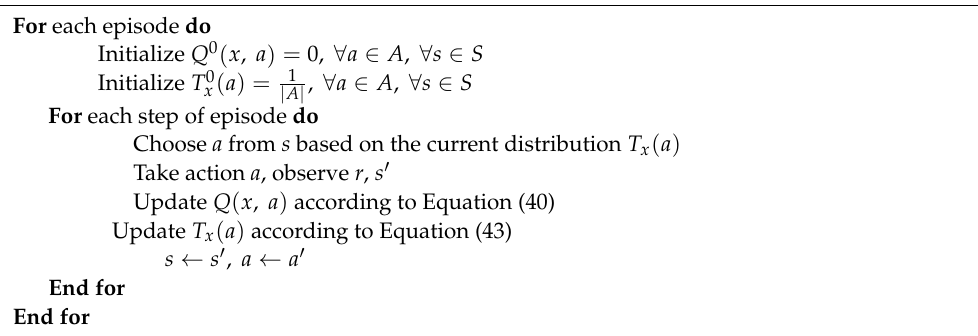
Algorithm 1 Q-learning-Based Adaptive Parameter in Rotor-Side